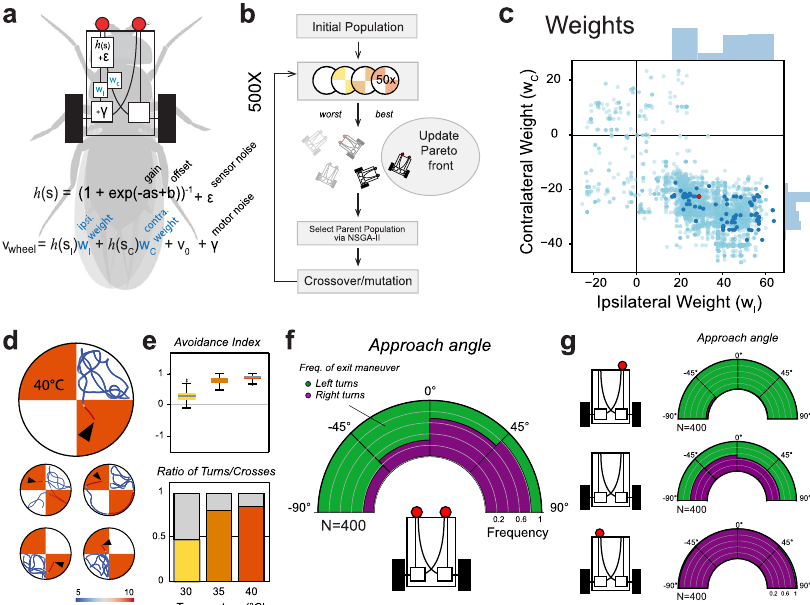
Fig. 5 An evolved “ Braitenberg vehicle ” nearly reproduces fl y thermotaxis. a An in silico “ Braitenberg vehicle ” model matching the dimensions of a fl y, with key parameters used as substrate for evolution ( s = sensory input, v velocity; parameters: a gain, b offset ε , γ noise (2 evolved parameters each, see methods), w i , w c = weights of ipsi- and contralateral connections). b Schematic of the evolutionary process used to optimize the parameters. c Connectivity weights. Note that the best performing vehicles (dark blue dots) preserve both ipsi- and contralateral connectivity, and that ipsilateral weights are exclusively positive (excitatory) while contralateral weights are exclusively negative (inhibitory). d – f An evolved vehicle (red dot in ( c )) nearly reproduces fl y thermotactic behavior in a simulated arena. d Traces from a top-performing vehicle in the simulated arena (see Supplementary Fig. 5 and “ methods ” for details; arrowhead = start). e , f Vehicle performance in the simulated chamber ( N = 400 simulations). g Vehicle responses are not robust to perturbation. “ Ablation ” of a single sensor produces vehicles that, entering the cool/hot boundary, invariably turn to the side of the lesion, irrespective of the direction of approach (mid-panel: as a control, removal of both sensors abolishes directional responses; N = 400 simulations